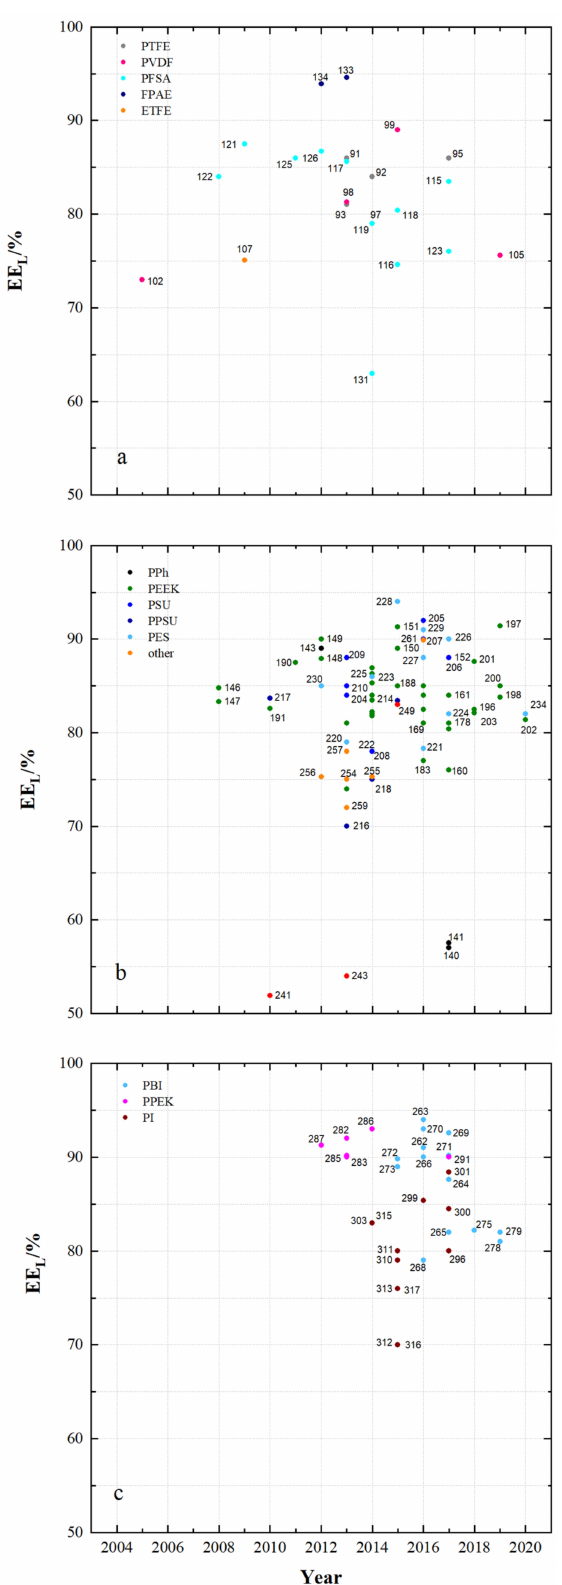
Figure 4. The energy efficiency of VRFB cells at current densities < 100 mA cm − 2 using: ( a ) fluoro- carbons, ( b ) hydro-carbons and ( c ) N